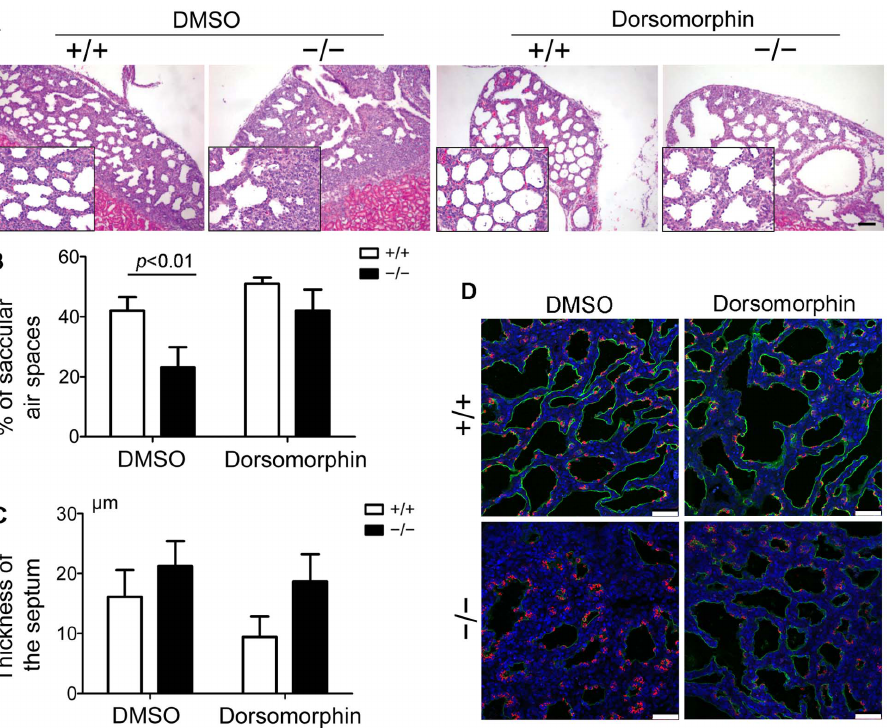
Figure 5. Reducing Bmp4 signaling activity rescued atelectasis phenotype of Fstl1 2 / 2 lung allografts. Diced E15.5 WT or Fstl1 2 / 2 lung allografts were implanted underneath the renal capsule of mice with or without Dorsomorphin treatment and cultured for 3 days. (A) Dorsomorphin increased saccular dilation of Fstl1 2 / 2 lung allografts. H&E staining of allograft sections shown at low and high (inserts) magnification. After Dorsomorphin treatment, Fstl1 2 / 2 lung allografts had more dilated sacs. Scale bar, 200 m m. (B) Quantification of saccular air spaces at the periphery in renal allografts from each experimental group (n=3). The graph represents the mean 6 SEM of three independent experiments. (C) Quantification of thickness of the septum at the periphery in renal allografts from each experimental group (n=3). The graph represents the mean 6 SEM of three independent experiments. (D) Dorsomorphin increased T1 a staining but decreased pro SP-C staining in Fstl1 2 / 2 lung allografts. Sections of WT or Fstl1 2 / 2 lung allografts were immunostained with Pro SP-C and T1 a antibodies. Red color: Pro-SPC; Green color: T1 a ; blue color: DAPI. Scale bar, 50 m m.